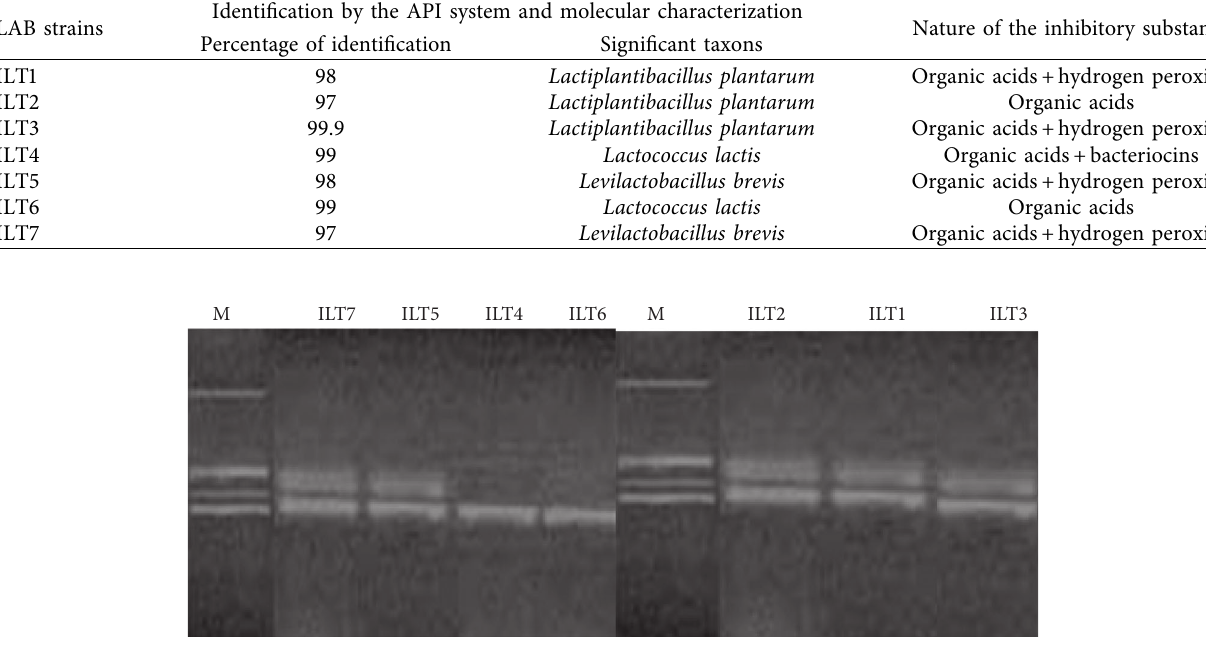
Figure 1: Amplification profile by 16S / 23S primers on agarose gel (1.5%). M: 100 bp marker (Promega, USA). Table 2: Antimicrobial potential of selected LAB strains against six pathogenic bacteria. Indicator LAB strains